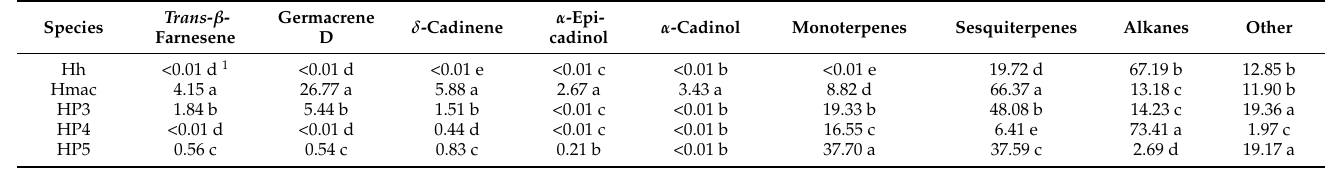
Table 2. Mean concentrations (%) of trans- β -farnesene, germacrene D, δ -cadinene, α -epi-cadinol, α - cadinol, monoterpenes, sesquiterpenes, alkanes, and other compounds obtained from the six species.